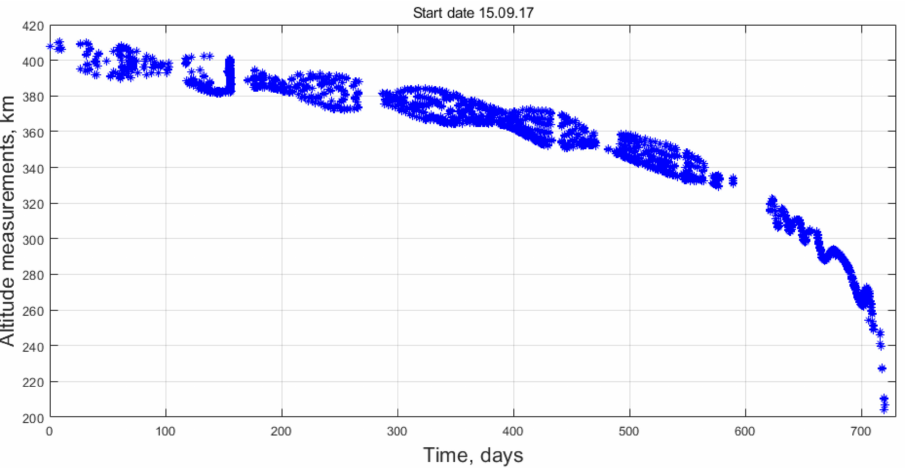
Figure 12. Altitude for the whole mission lifetime according to the onboard GPS/GLONASS receiver.